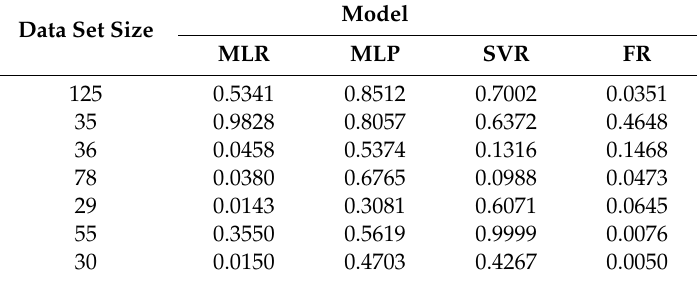
Table 8. Statistical comparison p -values based on Wilcoxon test or t − paired test, as appropriate, between SMFC and each of the other three models MLR, MLP, and